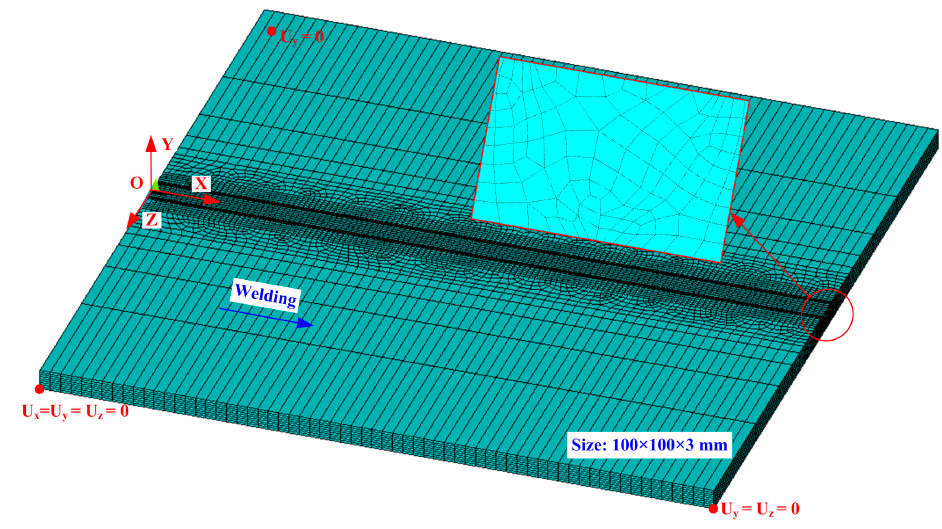
Figure 5. 3D mesh and free state.